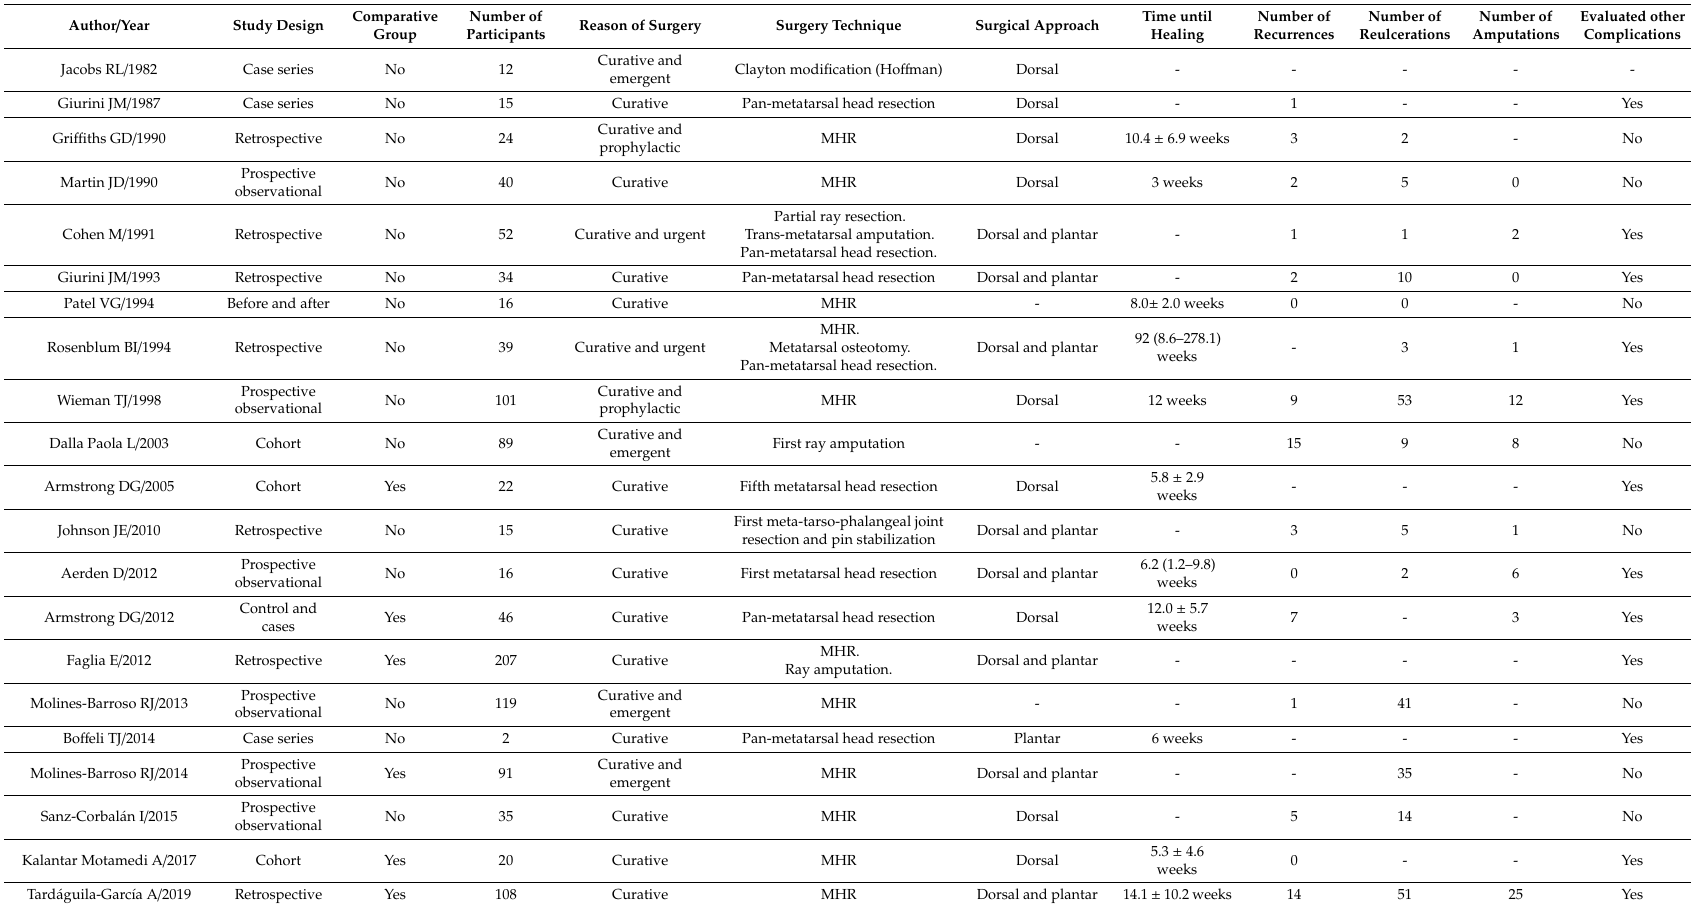
Table 1. Characteristics of studies included in the systematic